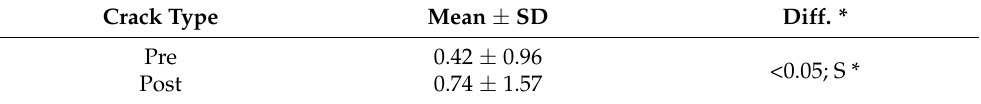
Table 2. Pre- and post-treatment crack type variation analyzed by Wilcoxon paired signed rank test. Crack Type Mean ± SD Diff. * Pre 0.42 ± 0.96